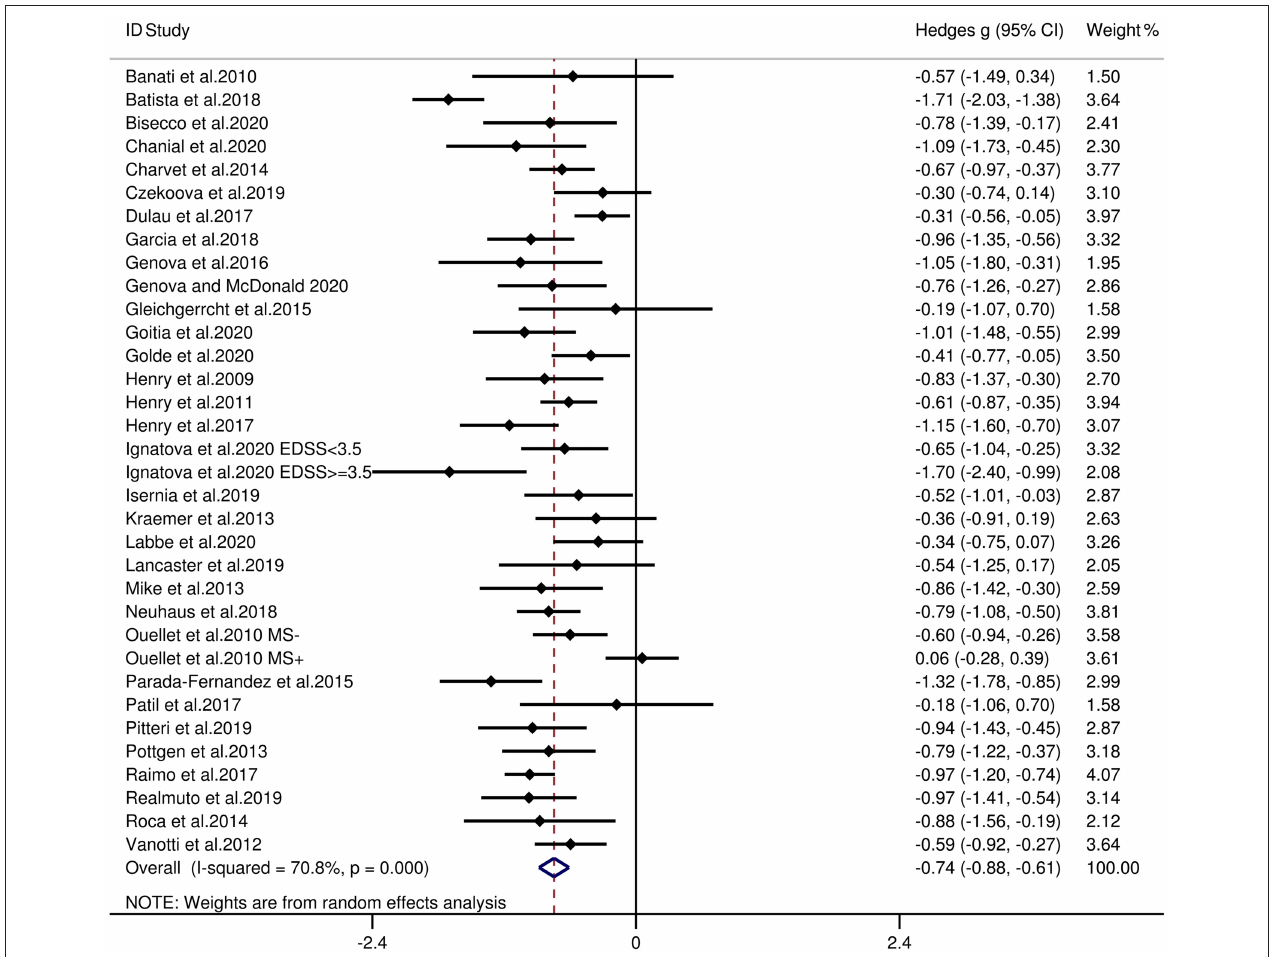
FIGURE 3 | Forest plots showing effect size estimates (Hedges g) for overall ToM differences between MS and healthy controls. CI, confidence interval; MS, multiple sclerosis; ToM, theory of mind.